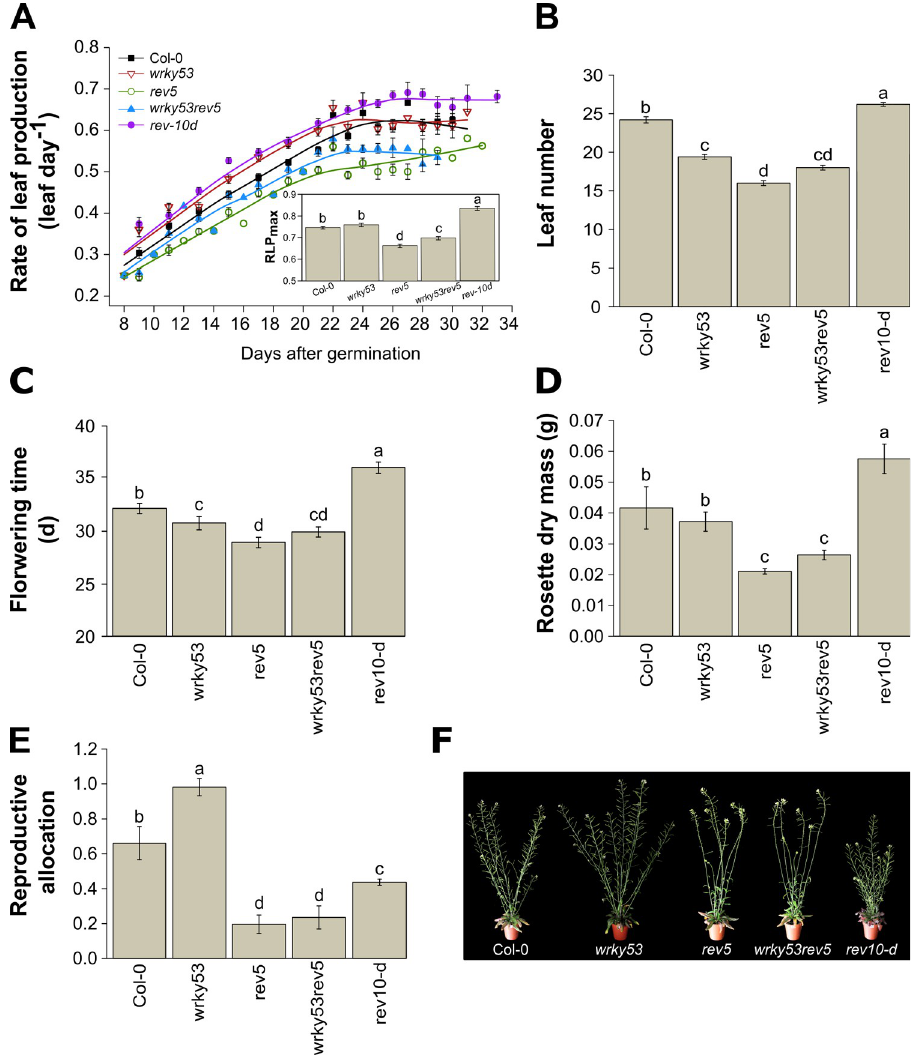
Fig 4. Developmental analysis of the different REV and WRKY53 mutants. (A) Rate of leaf production (RLP) during days after germination. Leaf number was counted from the two first true leaves until bolting. Insert in A represents the maximum RLP calculated as the slope (leaf per day), estimated by fitting a linear curve for each plant over time. (B) Leaf number at flowering. (C) Time to reach flowering. (D) Rosette dry mass at bolting. (E) Reproductive allocation at mature silique stage, calculated by the ratio of total silique dry mass per rosette dry mass. (F) A representative picture of rosettes and reproductive organs of the different genotypes at the mature silique. Bolting was defined by the emergence of the flower buds. Flowering was reached when the first flower was open and mature silique stage was considered from the first yellowing siliques. Data are means ( ± SE) of 5–30 plants per genotype. The different letters indicate significant differences following Kruskal–Wallis tests ( P � 0.05). See also S2 and S3